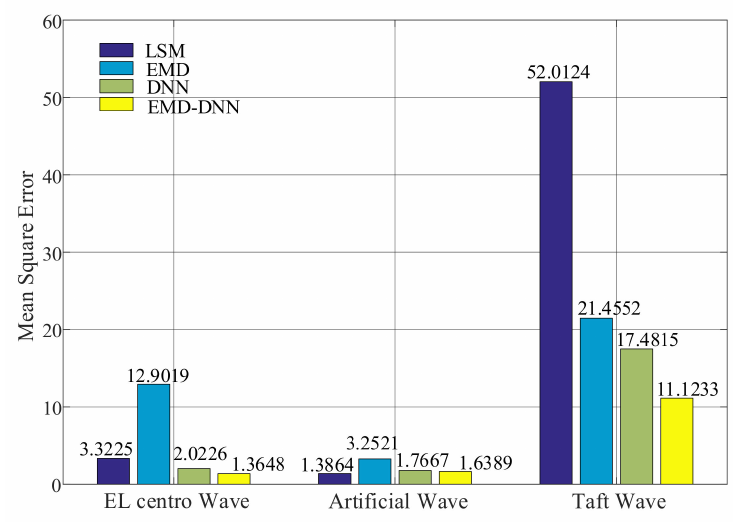
Figure 13. Mean square error (MSE) of different correction methods.